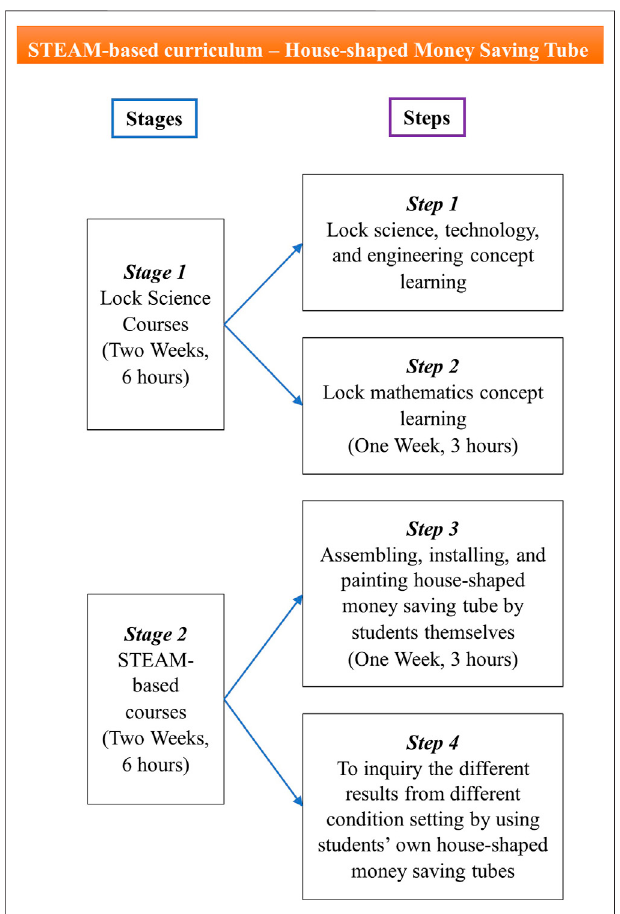
FIGURE 2 | The STEAM-based curriculum design of the house-shaped money-saving